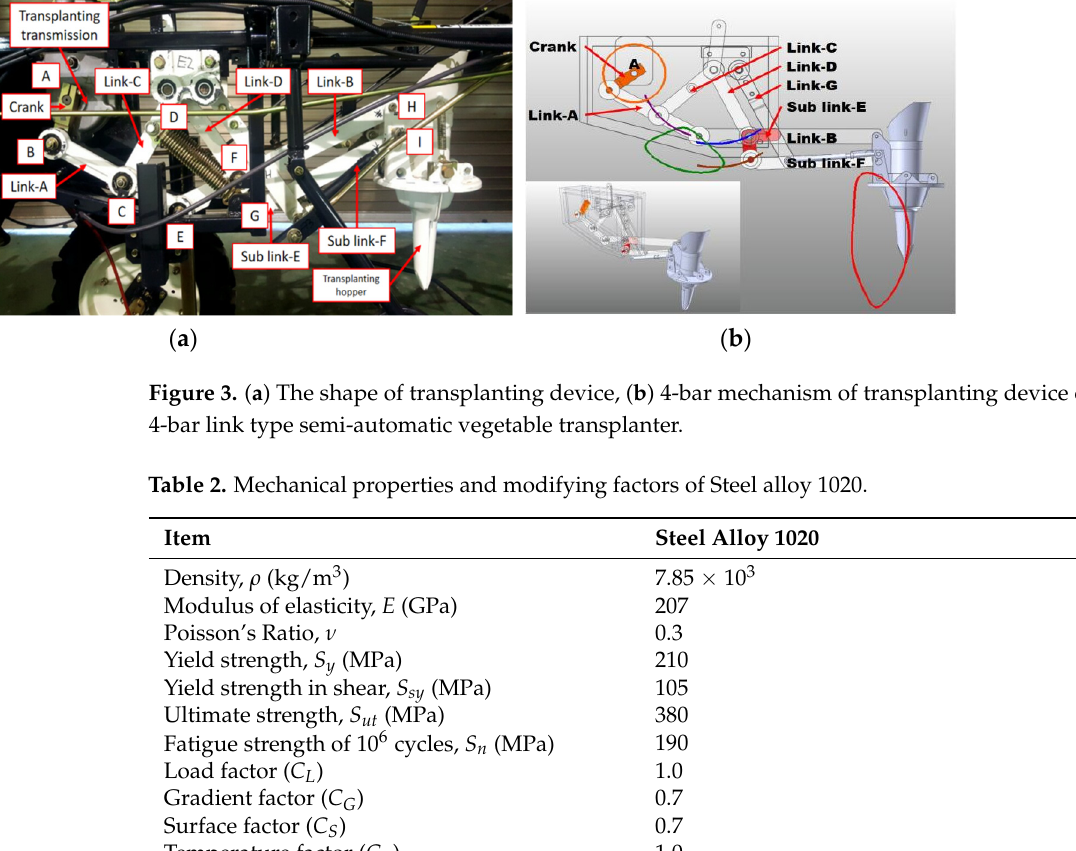
Figure 2. The trajectory of the hopper end of the transplanting device: ( a ) at stationary condition, ( b ) at mobile condition.